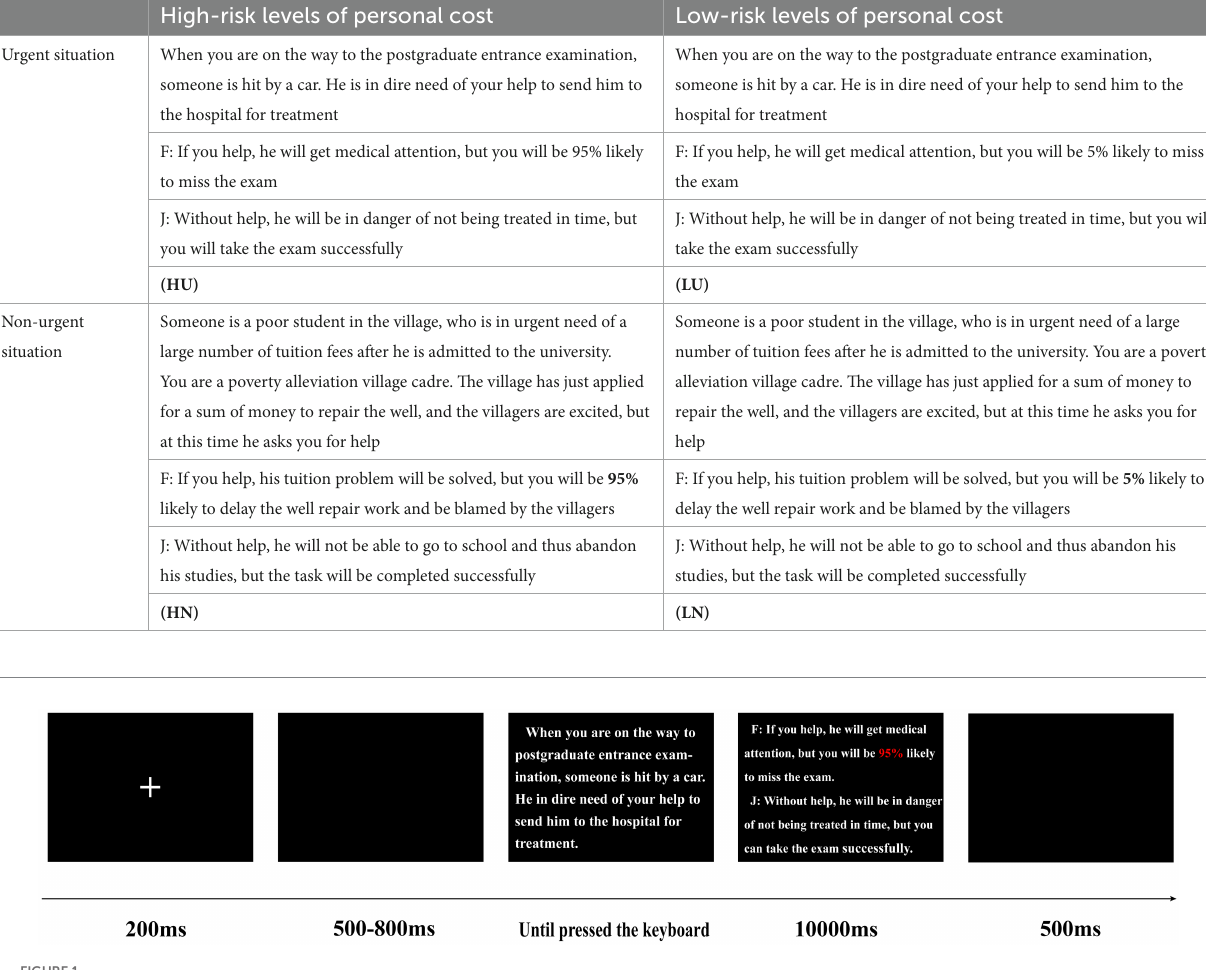
TABLE 1 The sequence of a single trial in the prosocial risky behavior task. High-risk levels of personal cost Low-risk levels of personal